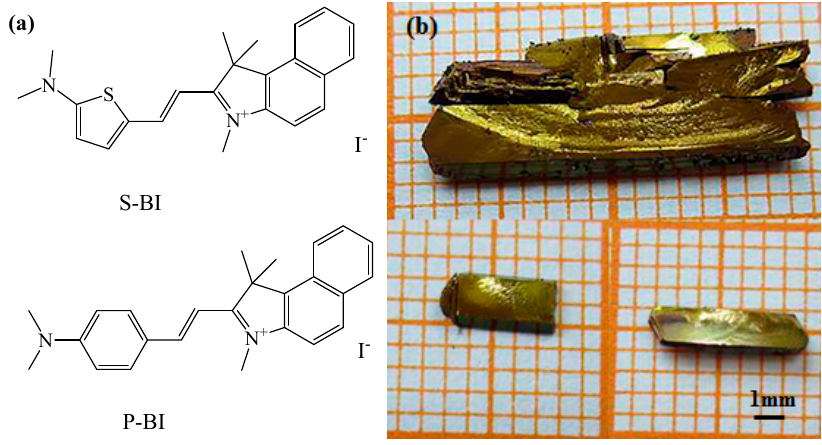
Figure 16. Molecular structures of S-BI and P-BI ( a ) and single crystals of P-BI ( b ).